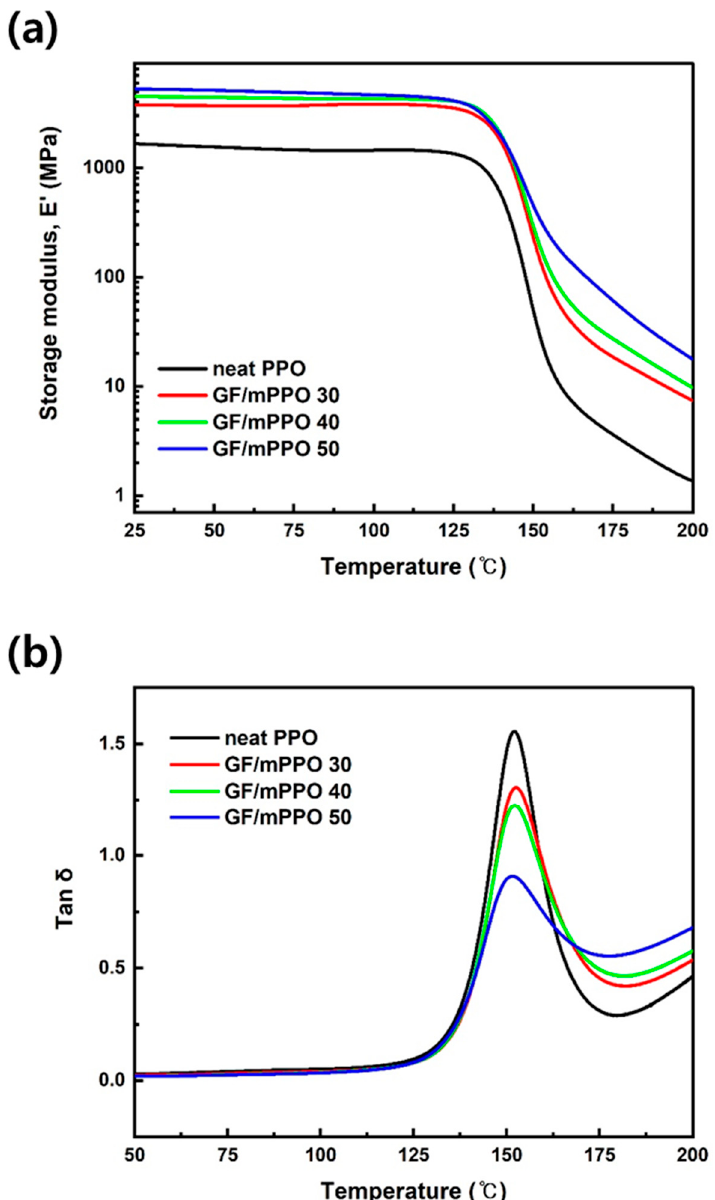
Figure 9. DMA results of the neat mPPO and GF/mPPO composites; ( a ) storage modulus, and ( b ) tan δ .